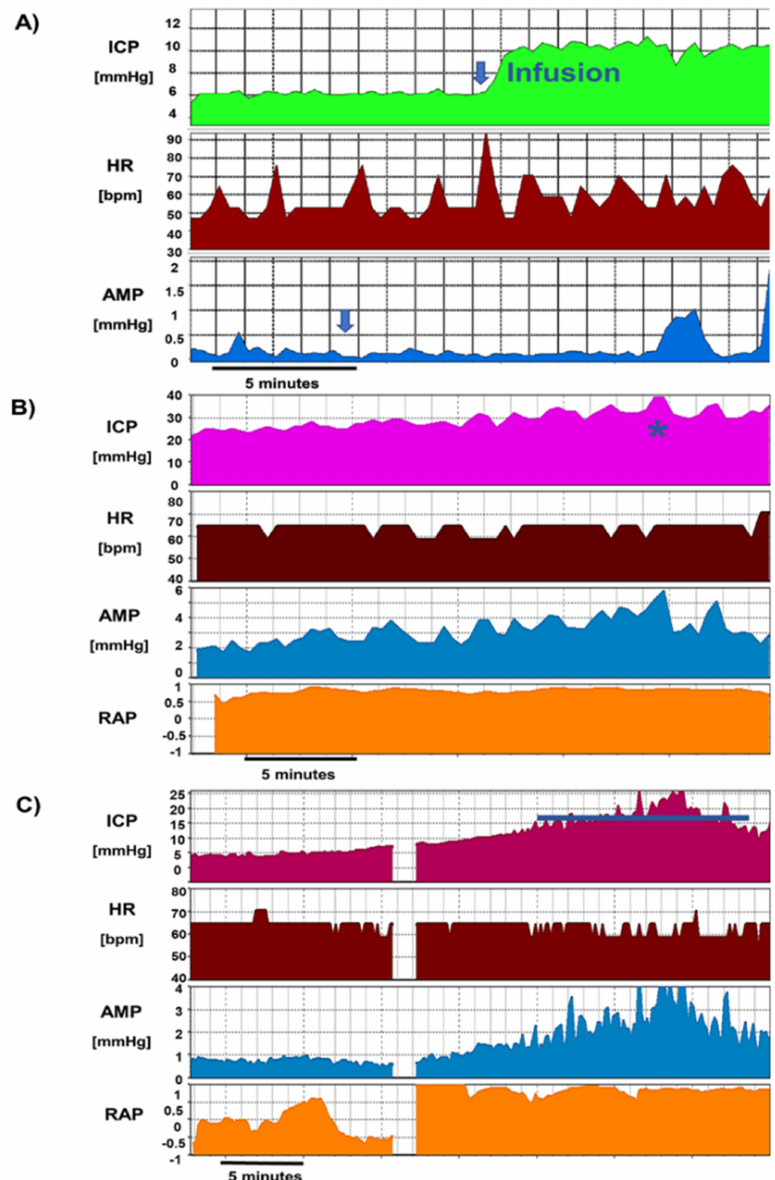
Figure 12. Malfunctioning shunts. ( A ) Proximal obstruction: no pulsatile pressure detected, steep jump in pressure after start of infusion, and no signs of pulsatility during infusion. ( B ) Distal obstruction: clearly raised, pulsatile baseline pressure. ( C ) Underdrainage despite patent distal end: ICP plateau slightly exceeding critical pressure, Rout mildly raised. Distinction between underdrainage and distal obstruction is difficult. Slightly raised Rout and plateau pressure from expected values usually indicate against distal obstruction. Increased intra-abdominal pressure could be considered, or closer monitoring of the patient due to risk of future obstruction. The data gap in this panel is due to artefact removal (artefact had been generated due to patient